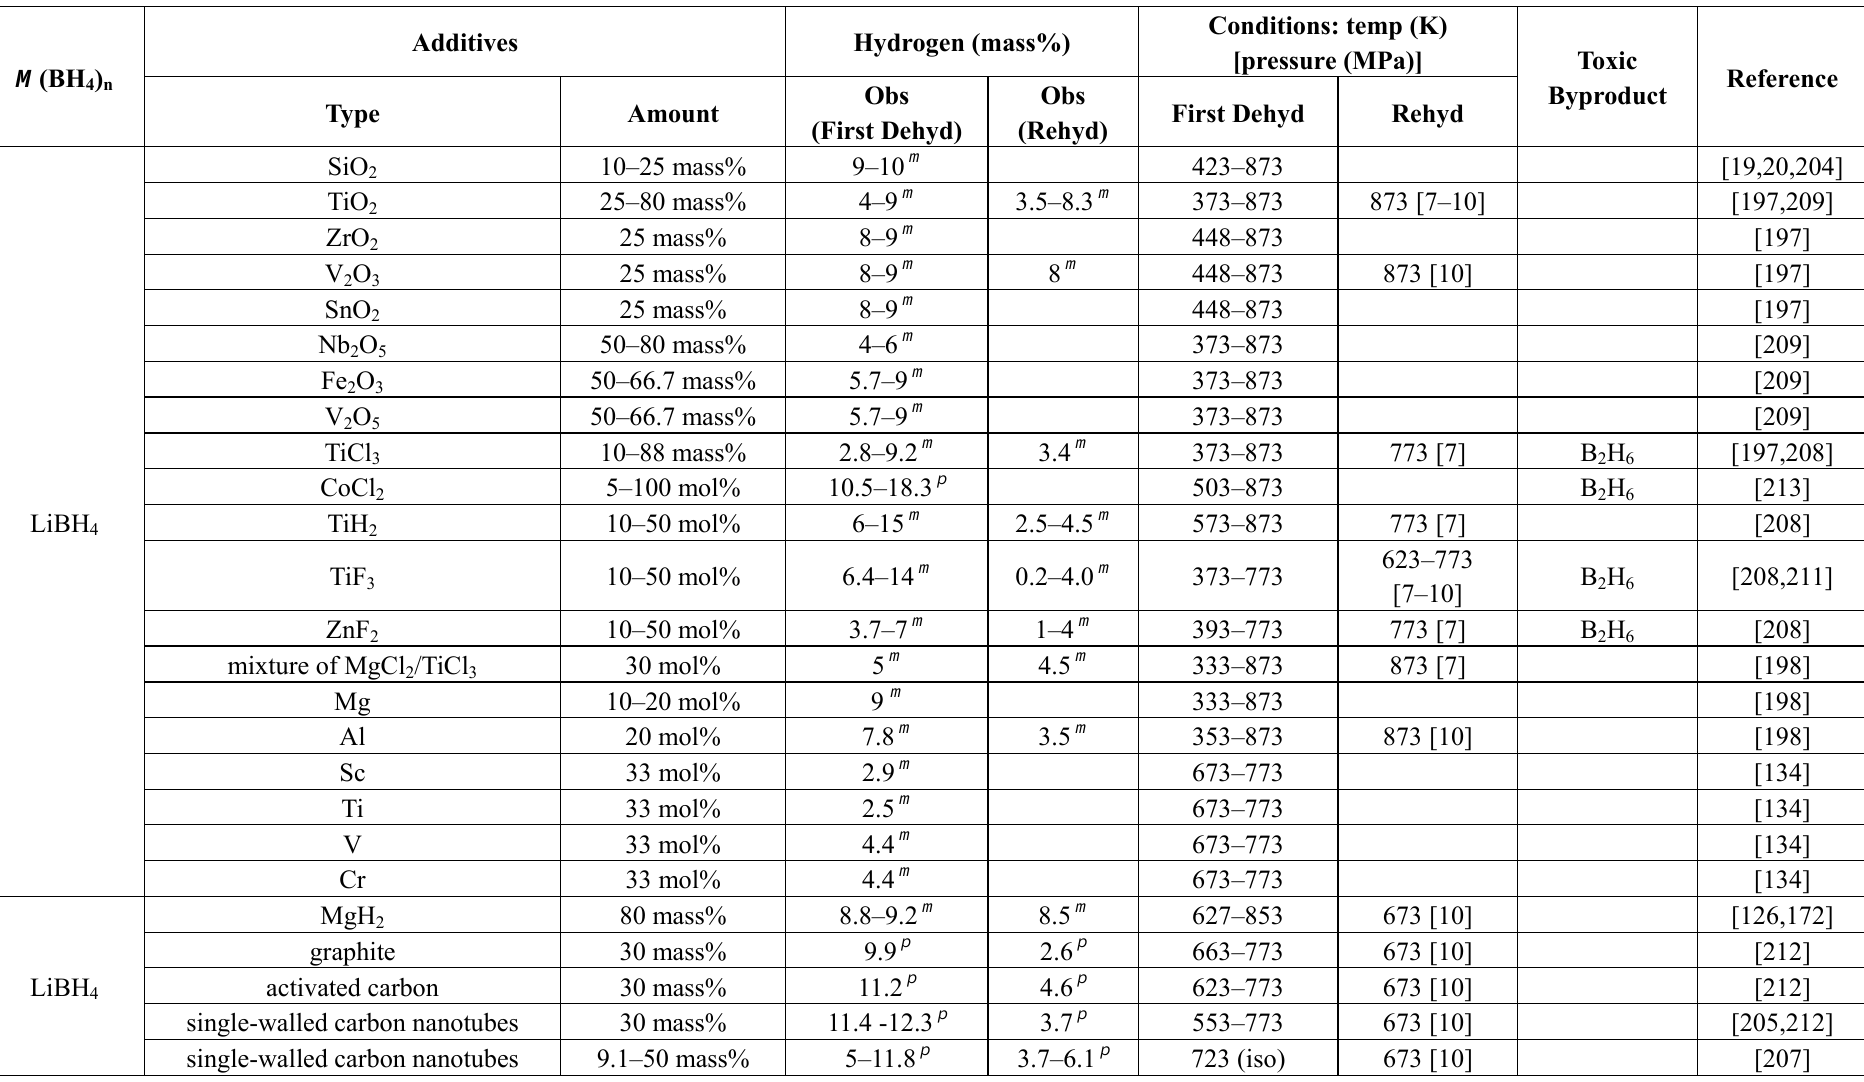
) with additives (oxides, halides, carbon, etc .). 4 n